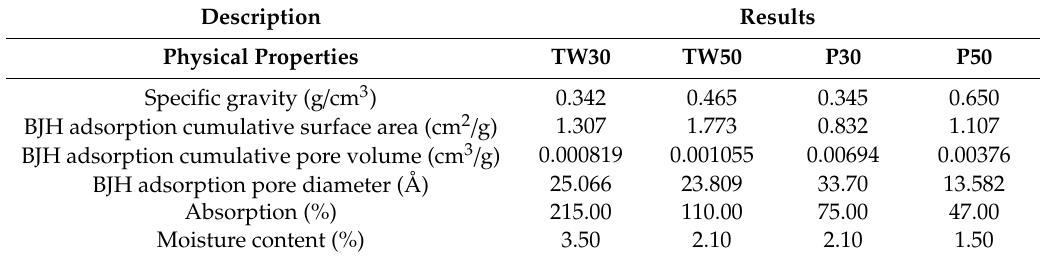
Table 2. Physical properties of two di ff erent used types of tea waste and perlite